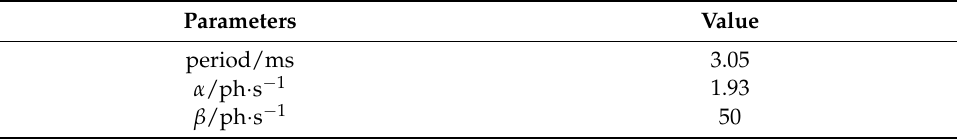
Table 1. Simulation parameters of PSR B1821-24